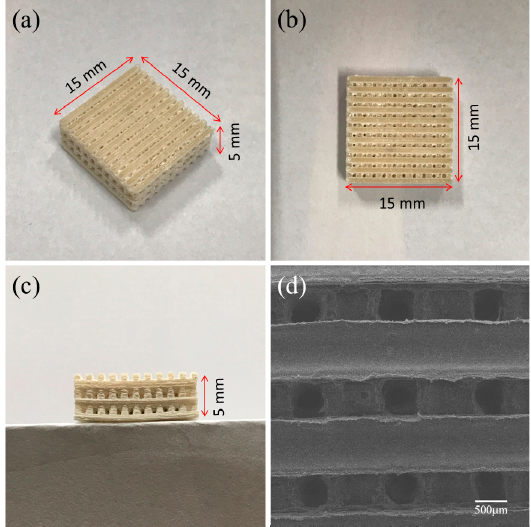
Figure 2. ( a – c ) Optical images and ( d ) SEM morphology of a representative three-dimensional rectangular PHBV/10%CS porous scaffold fabricated via SLS (selective laser sintering).